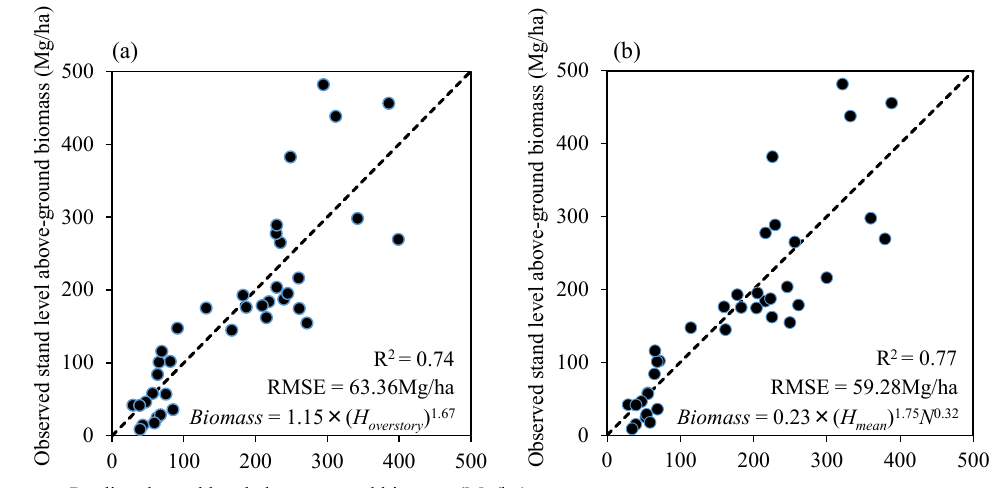
Figure 5. Observed and predicted biomass estimation: ( a ) one variable; ( b ) two